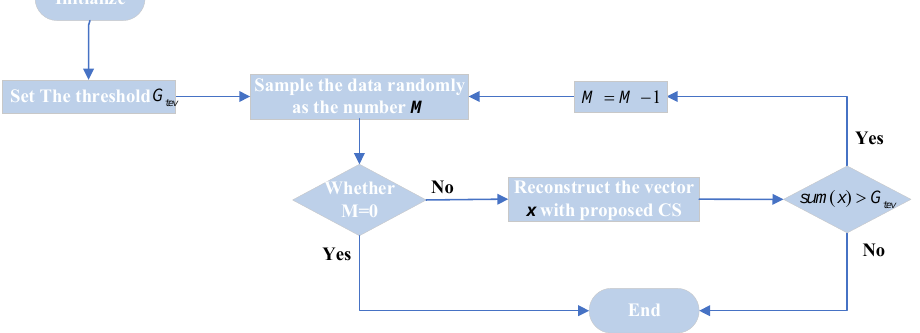
Figure 3. Flow chart of the anti ‐ jamming method based on CS theory.